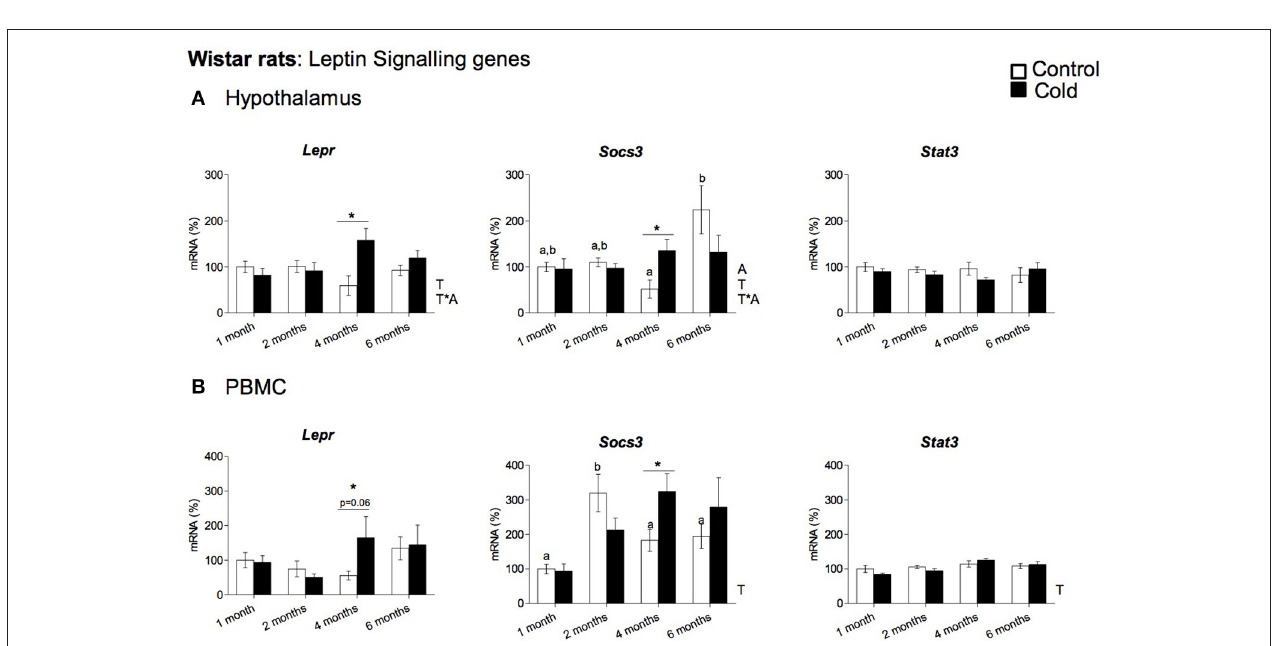
FIGURE 3 | Gene expression of leptin signaling related genes ( Lepr , Socs3 and Stat3 ) measured by qRT-PCR in (A) hypothalamus and (B) PBMC of rats (from 1 to 6 months) housed at different room temperatures: 22 ◦ C (control) or 4 ◦ C for 1 week (cold). Results represent mean ± SEM ( n = 5–6) of ratios of specific mRNA levels relative to Gdi for hypothalamus and Lrp10 for PBMC , expressed as a percentage where the 1-month control group was set as 100%. Bars not sharing common letters (a,b) are significantly different (one-way ANOVA, p < 0.05). DMS post-hoc was used after one-way ANOVA analysis. *Effect of cold exposure (cold-exposed rats vs. their respective controls; Student’s t -test, p < 0.05, or indicated when different). Two-way ANOVA ( p < 0.05) was performed for cold and control conditions (T) and age (A). For this statistical analysis: T indicates effect of temperature, A effect of age, and T *A the interaction of temperature and age.